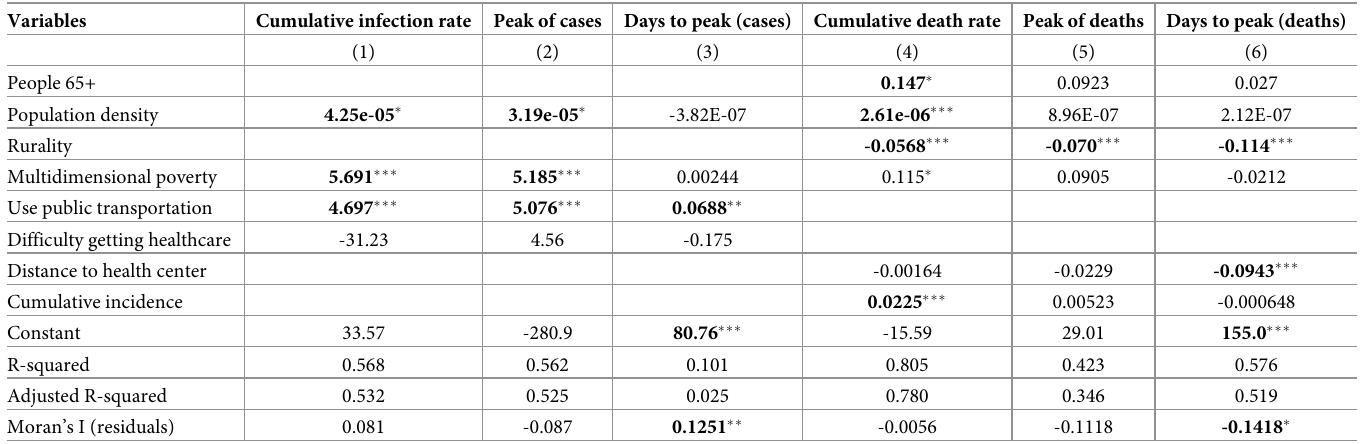
Table 6. Simplified regressions